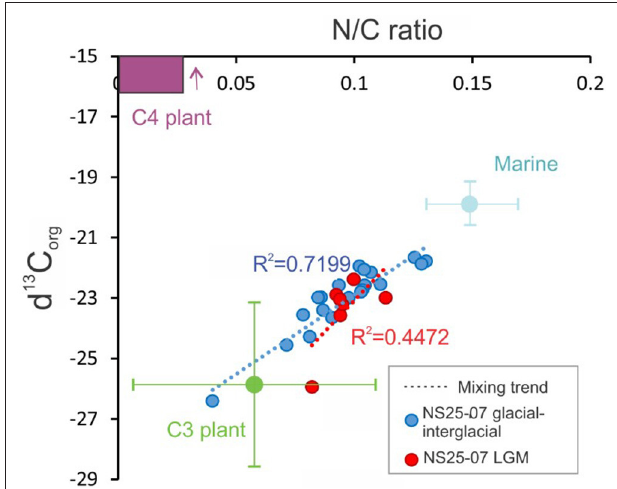
FIGURE 6 | The δ 13Corg and N/C scatter plot (Zheng et al., 2017) for the samples from NS07-25 sediment. Blue dots indicate the time period other than the LGM. Red dots indicate the LGM time period. Dashed lines indicate the mixing trend or the contribution to the OM of NS07-25t from C3 plants (green) C4 plant (purple) and marine OM (light